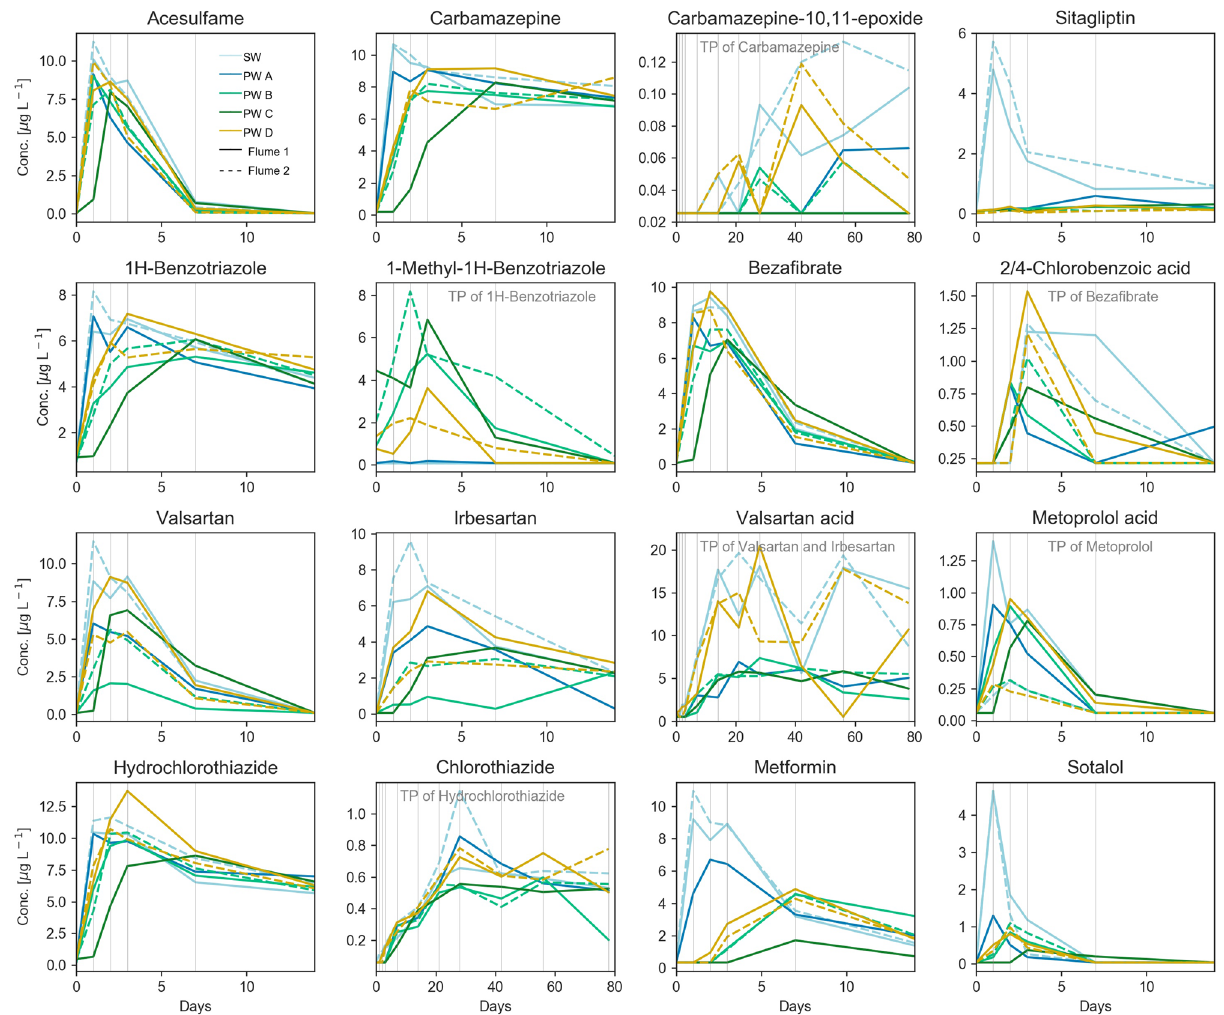
Figure 2. Measured concentrations in the SW, in PW Samplers A, B, C and D in Flume 1 and PW Samplers B and D in Flume 2 of selected compounds and related TPs. Grey vertical lines indicate sampling days. Note the differences in scales of the x- and y-axes. For concentrations of all compounds see Supplementary Fig. S1 (78 days) and Fig. S2 (7